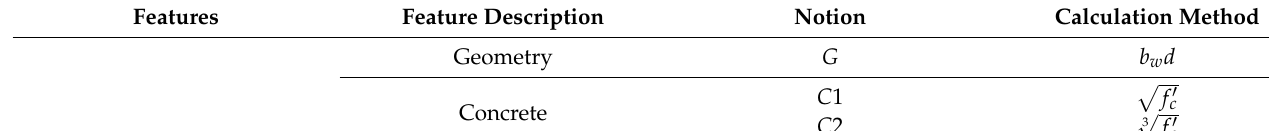
Table 3. Artificially selected input